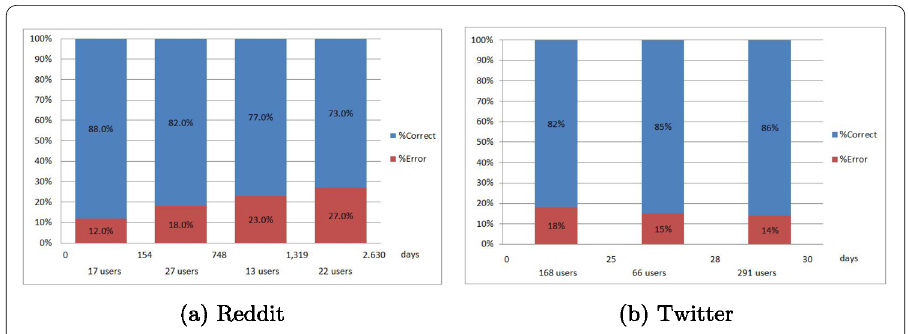
Figure 6 Error percentages by temporal expansion in the Reddit and Twitter collections. The x-axis represents the observation time intervals per user; in Reddit the maximum temporal expansion is of 2630 days, in Twitter only 30